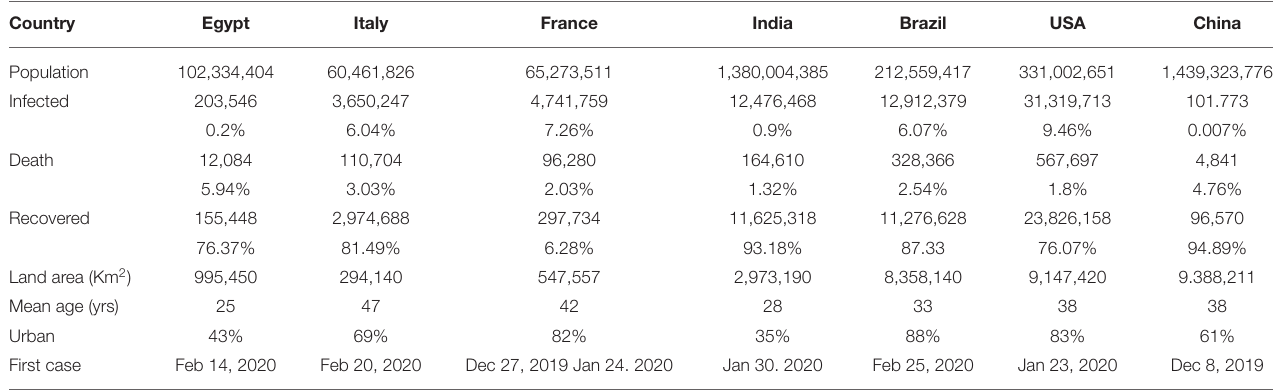
TABLE 2 | COVID-19 statistics in Egypt, Italy, France, India, Brazil, the USA, and China. Country